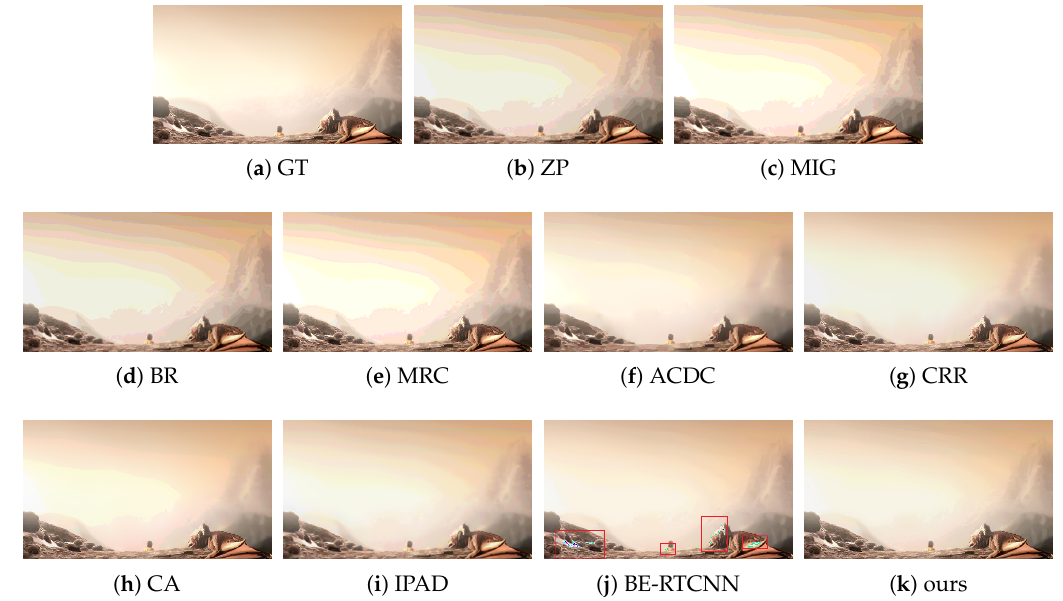
Figure 4. The BDE results on 4bit-16bit synthetic image from sintel-8 dataset